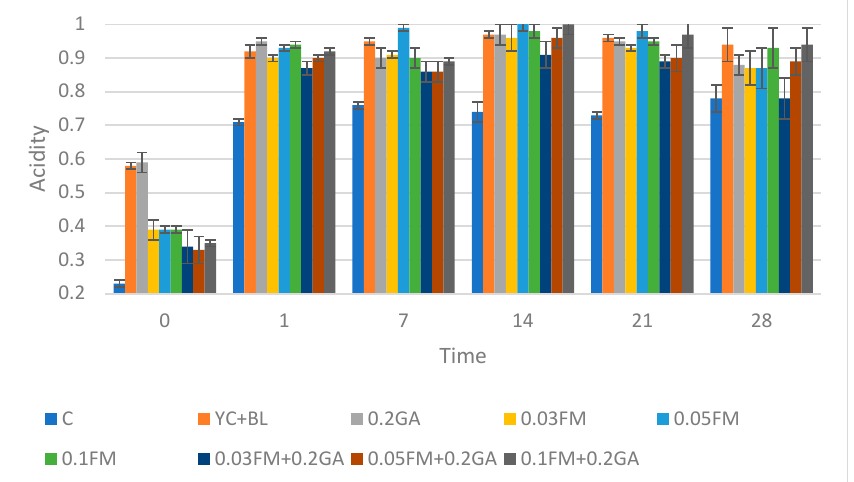
Figure 2. Effect of addition of FM, GA, yogurt culture and B. lactis at different concentration on acidity value in kefir samples. Abbreviations: C, control; YC, yogurt culture; B.L, B. lactis ; GA, gum arabic; FM, flaxseed mucilage.